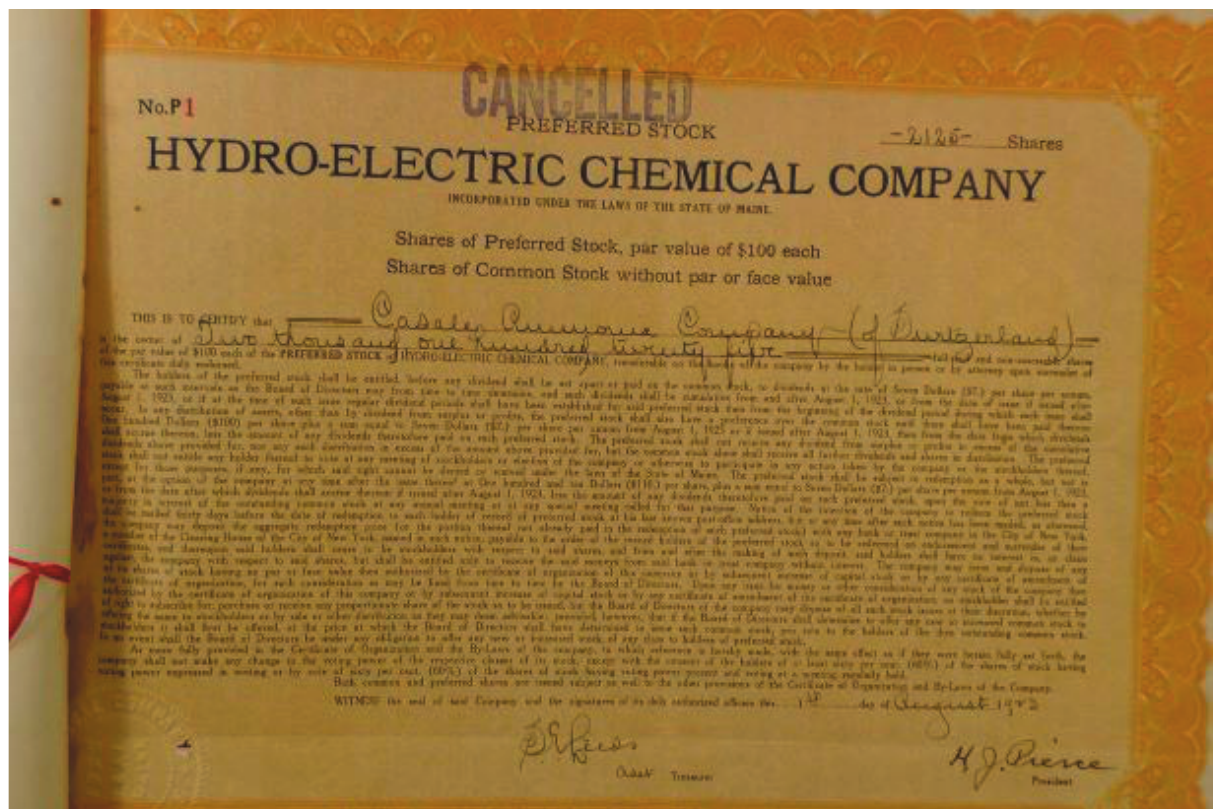
Figure 3. Stock certificate, Hydro-Electric Chemical Company, preferred stock, in the name of the Casale Ammonia Company (often used in English language documents for Ammonia Casale SA), 1 August 1923. From: Hydro-Electric Chemical Company, Stock Certificate book, 1923-28. Records of E.I. Du Pont de Nemours & Co. Absorbed companies. Hagley Museum and Library, Wilmington, Delaware, Accession 500, series II, part 1, box 848. Author’s photograph. Reproduced with